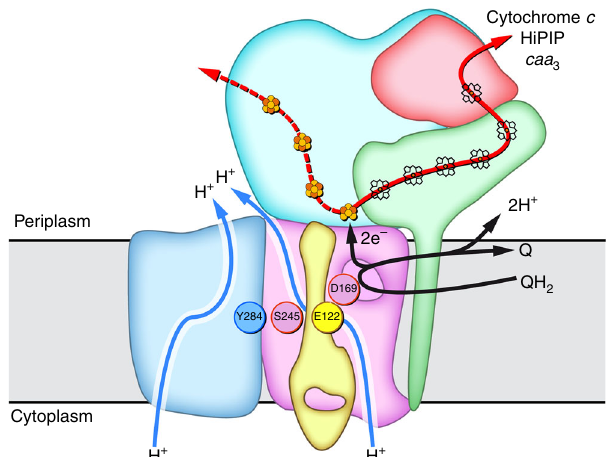
Fig. 8 ACIII as a redox-driven proton pump. Proposed coupling between electron transfer and proton translocation. Upon quinol oxidation (black arrows), electrons are transferred to FeS1 and subsequently through the electron wires (red arrows); electrons conducted through the heme wire reduce a soluble electron carrier such as cytochrome c or HiPIP, or the caa 3 oxygen reductase, as observed before 8, 10, 11 ; clusters FeS2 – 4 may be involved in further electron transfer (red dashed arrow). Concurrently, a protonation or conformation change of Asp169 C at the quinol-binding site may propagate through the conserved, neighboring residues Glu122 D , Ser245 C , and Tyr284 F (colored circles). The conformational changes of these residues, located in one plane at the end of the putative proton half- channels in ActC and ActF, will allow further conformational changes at the proton-conducting channels for proton transport across the membrane (blue arrows). ActH was not included for